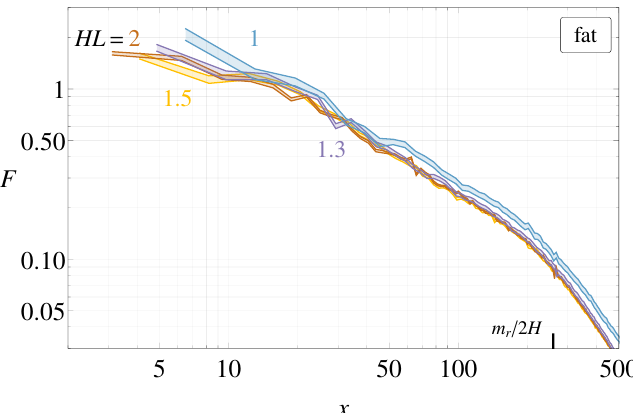
Figure 19: The instantaneous emission F for different values of H L at log = 6.4. For H L ≥ 1.5 finite volume effects do not alter the spectrum in the momentum range [ 30 H , m / 4 ] where q is extracted. The simulations are performed with m r = 1250 3 a N 3 x